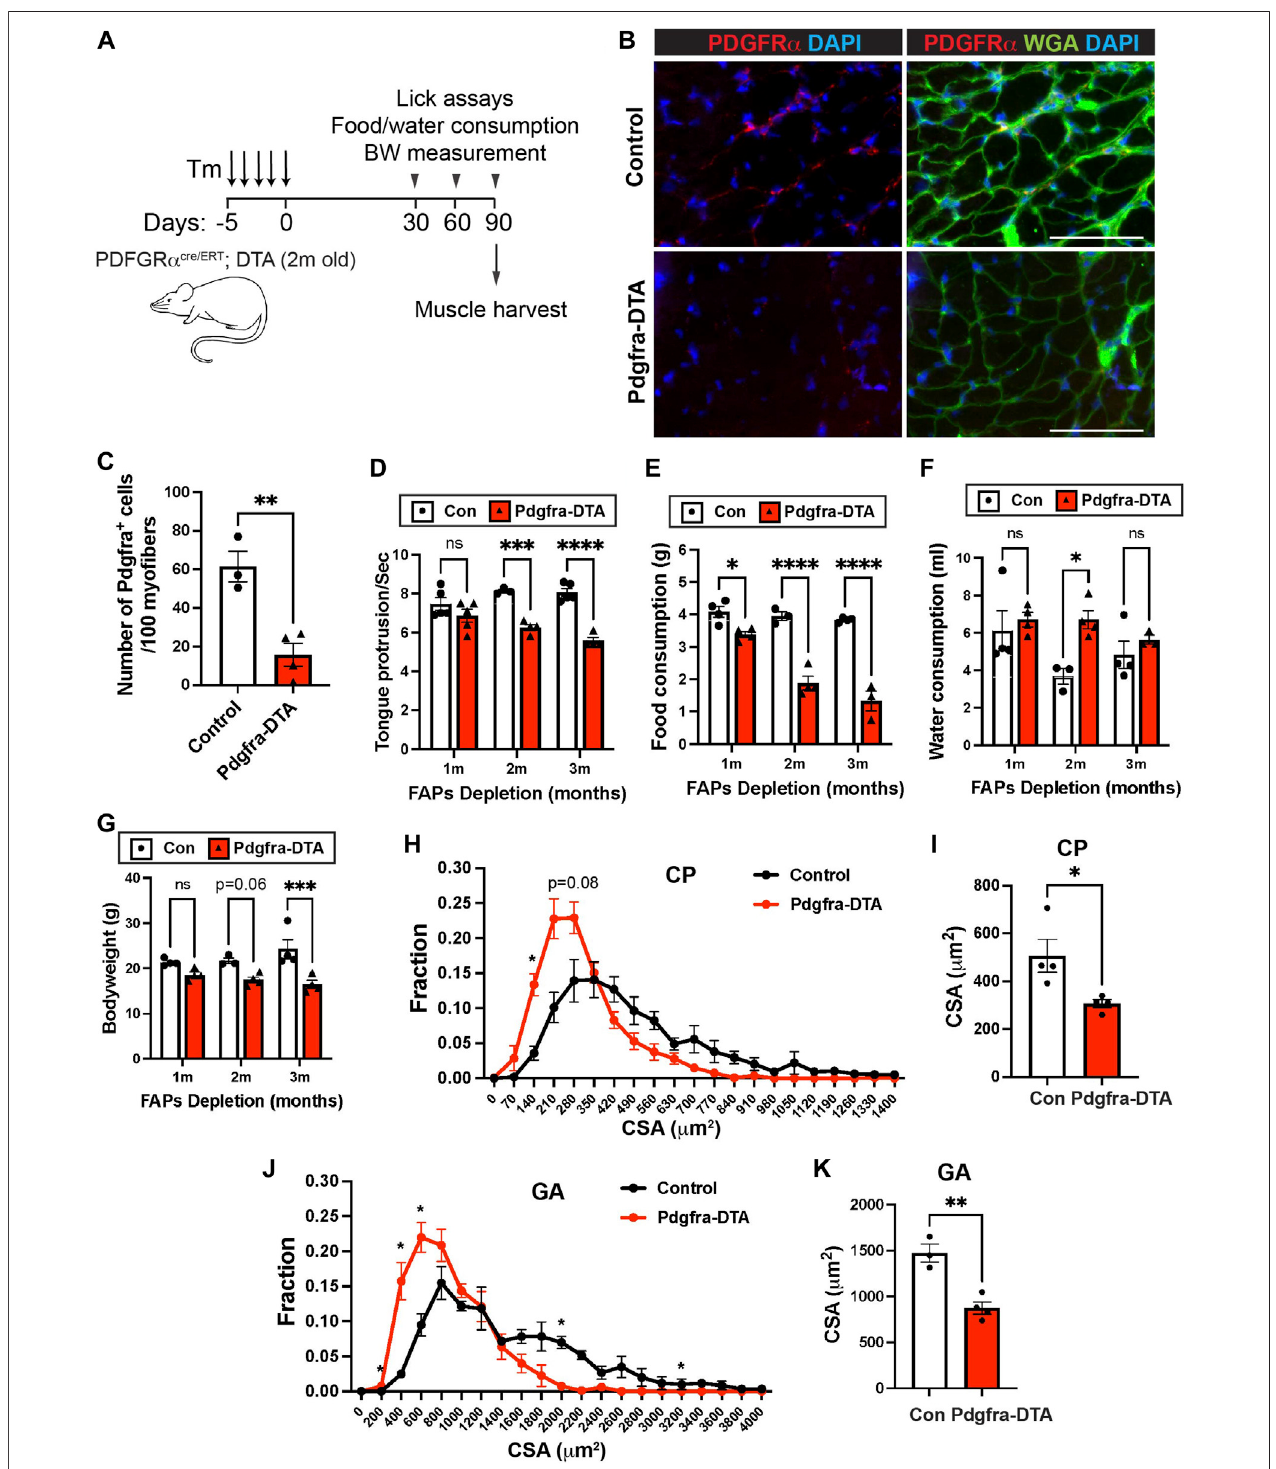
FIGURE7| FAPsarecriticalforpharyngealmusclefunctionandmaintenance. (A) SchemeofstrategyforsatellitecellablationusingPdgfra Cre ERT+/ − -DTA(Pdgfra- DTA, n = 3 – 4) and Pdgfra Cre ERT − / − -DTA (sex- and age-matched control, n = 3 – 4). Both groups were injected with Tamoxifen (Tm). Lick assay was performed at 1, 2, and 3 months post tamoxifen injection using the same cohort. Mice were sacri fi ced at 3 months of FAPs ablation for muscle harvest. (B) Representative images of PDGFR α + cells in pharyngeal (PH) muscles of control and Pdgfra-DTA mice after 3 months of tamoxifen injection. Merged images show immunostaining with anti- PDGFR α (Red) and anti-laminin (green) antibodies and DAPI (blue). Scale bars = 70 µm. (C) The quanti fi ed number of PDGFR α + cells per 100 myo fi bers. n = 4. (D)